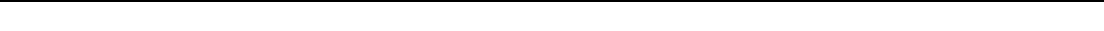
If a datazone contains 600 females, and 5% of the surface area of the datazone overlaps with the service area then 30 fe- males are assumed to live within the area accessible to a station. This is repeated for all datazones which overlap the surface area to calculate the total of each demographic group living within the 400m buffer. For continuous data, cars per household, cars per person and mean age we instead used the proportion of the service area covered by each datazone to weight the mean for each overlapping datazone according to the amount it ‘contributes’ to the total service area, based on surface